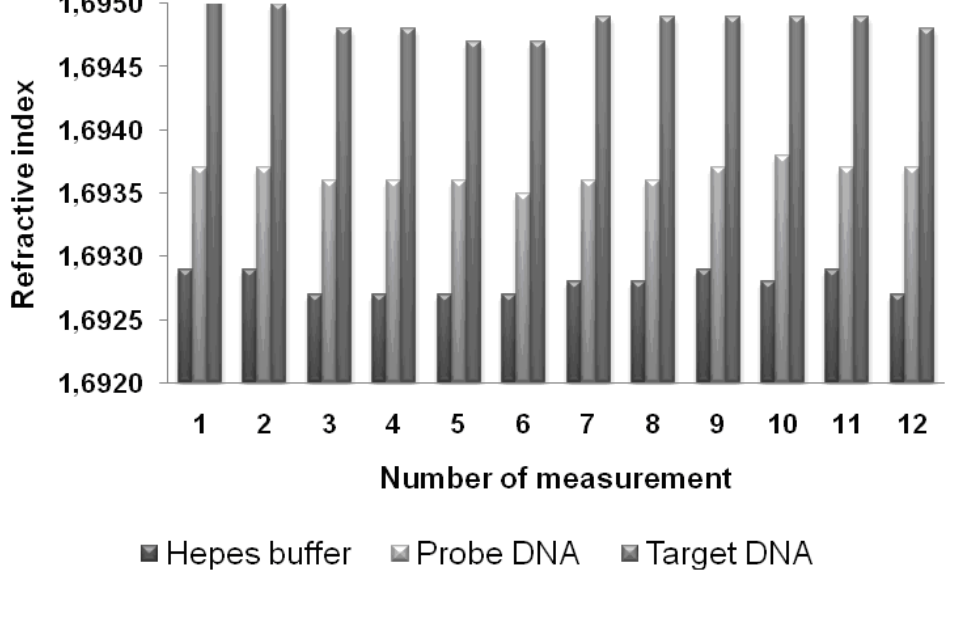
Figure 7. The bar chart of refractive index values versus number of measurements.